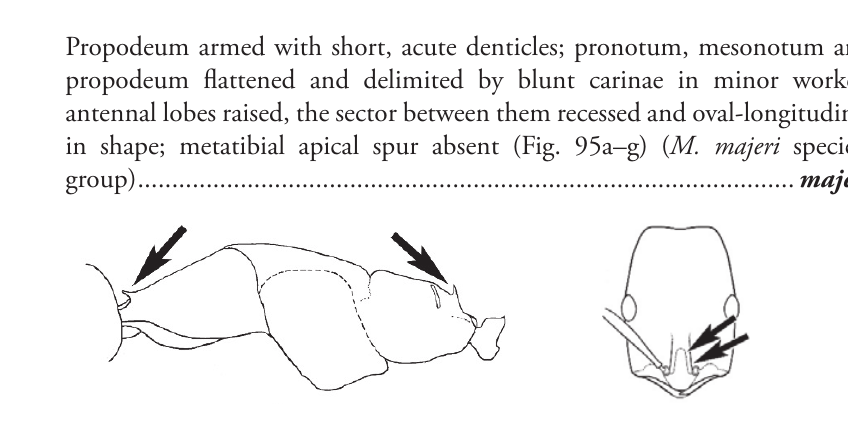
– Propodeum always unarmed; mesosoma never carinate as above, usually with rounded surfaces; if antennal lobes raised then sector contained within them triangular or hemispherical; metatibial apical spur well-developed in most 6 Head and mesosoma extensively covered with short, stout, peg-like bristles; in outline, pronotum and mesonotum flattened; metatibial apical spur stout but very short ( M . fulvihirtus species-group) ............................................... 7